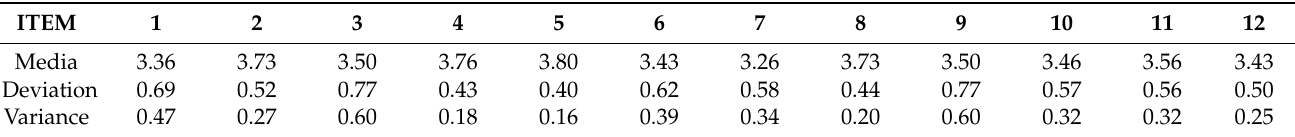
Table 7. Statistical values of the 12 questionnaire items.